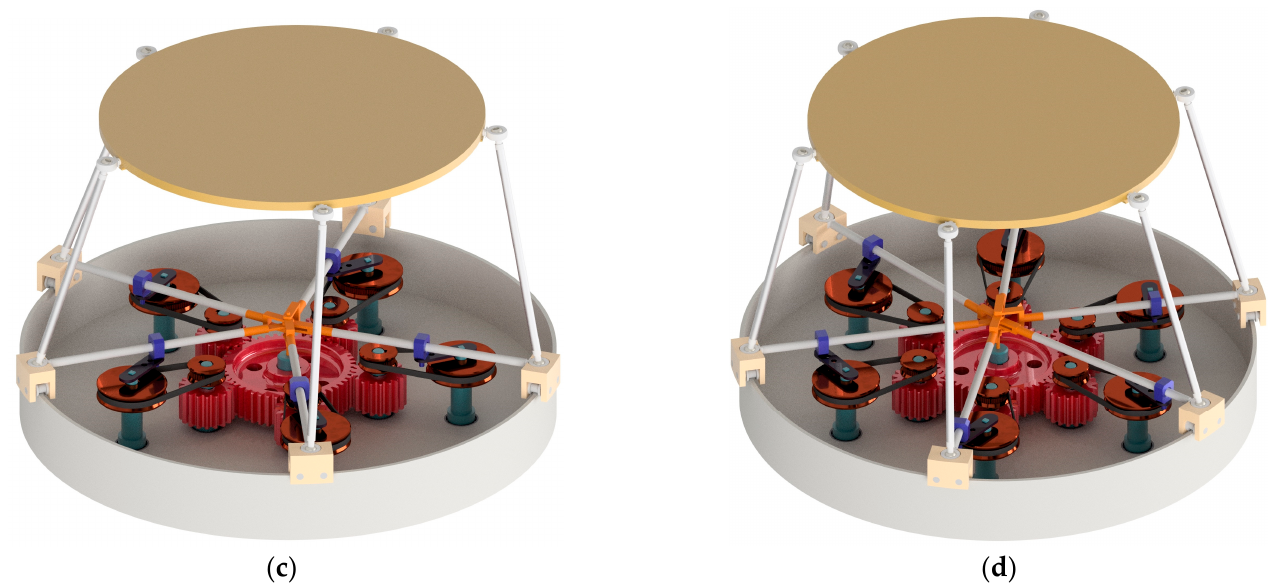
Figure 2. CAD models of the synthesized mechanisms with a reconfigurable design: ( a ) tripod; ( b ) quadropod; ( c ) pentapod; ( d ) hexapod.